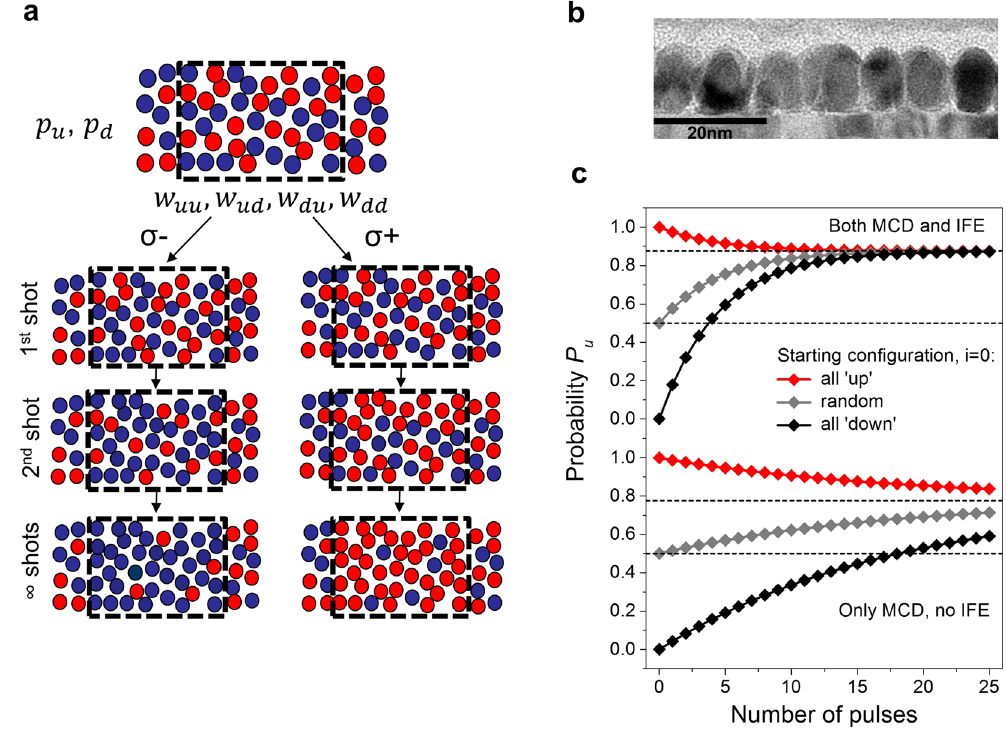
Figure 3. Microscopic structure and rate model. ( a ) Different switching probabilities lead to a final magnetisation of the FePt grain ensembles. The transition rates w uu , w ud , w du , w dd determine the number of grains in the ‘up’ or ‘down’ states, described by the probabilities p u and p d , after each single shot. ( b ) Structure of the nanosize FePt grains: transmission electron micrograph showing the FePt grains on the seed layer. The grains have a coercive field of a few Tesla at room temperature, keeping them robust to thermal fluctuations. ( c ) top: probability of being in an ‘up’ state ( p u ) versus number of laser pulses starting from three different initial states when the helicity-dependent thermal heating via the MCD and the non-thermal influence of the IFE are taken into account. c , bottom: probability of being in an ‘up’ state versus number of laser pulses starting from three different initial states when only the MCD is taken into account, not the IFE. The scenario corresponds to an average power onto the sample of 11 mW (9.6 mJ/cm 2 per